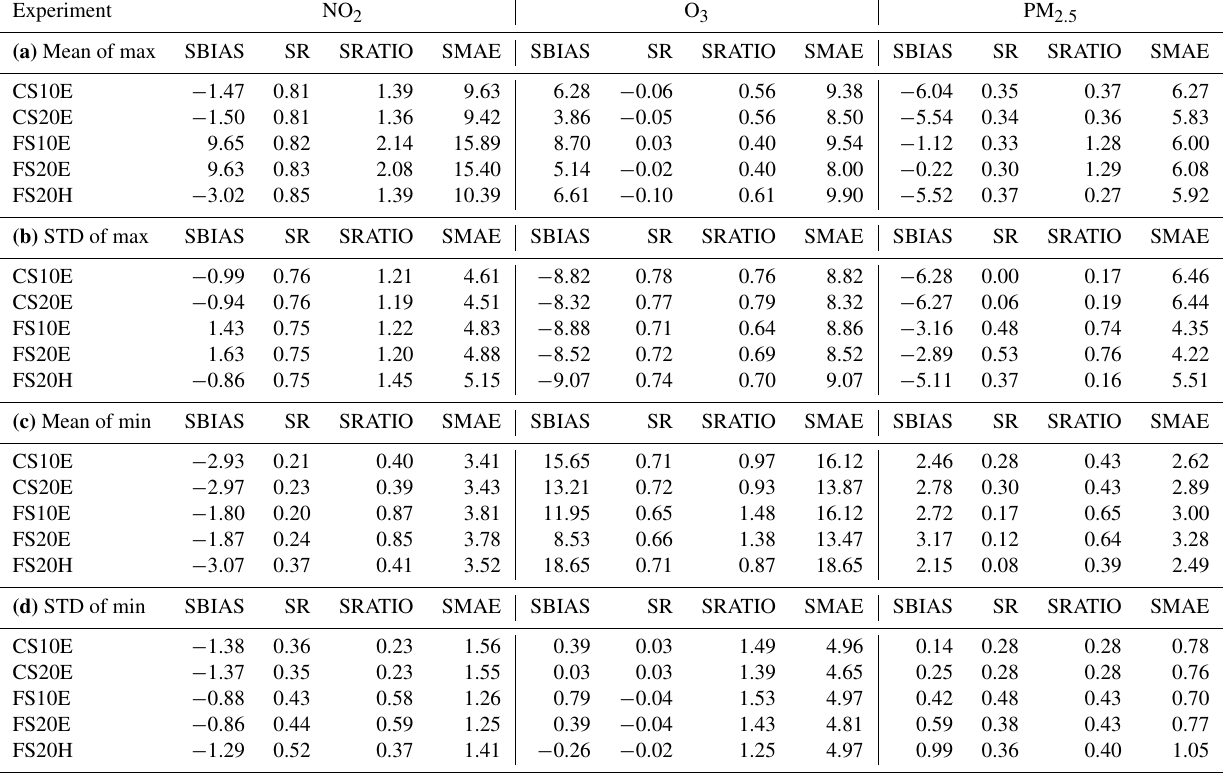
Table 4. Spatial verification results for Figs. 2, 3, 6 and 7 are displayed in the table sections a, b, c and d, respectively. Shown is the spatial mean difference (bias; µgm − 3 ), correlation coefficient, standard deviation ratio (modeled / observed) and mean absolute error (µgm − 3 ) calculated upon the modeled and observed temporal mean or standard deviation values at the stations shown in these figures. SBIAS: spatial bias, SR: spatial correlation coefficient, SRATIO: spatial standard deviation ratio, SMAE: spatial mean absolute error, mean: results for the pointwise temporal mean values, STD: results for the pointwise temporal standard deviation values, max: results for daily maximum concentrations, min: results for daily minimum